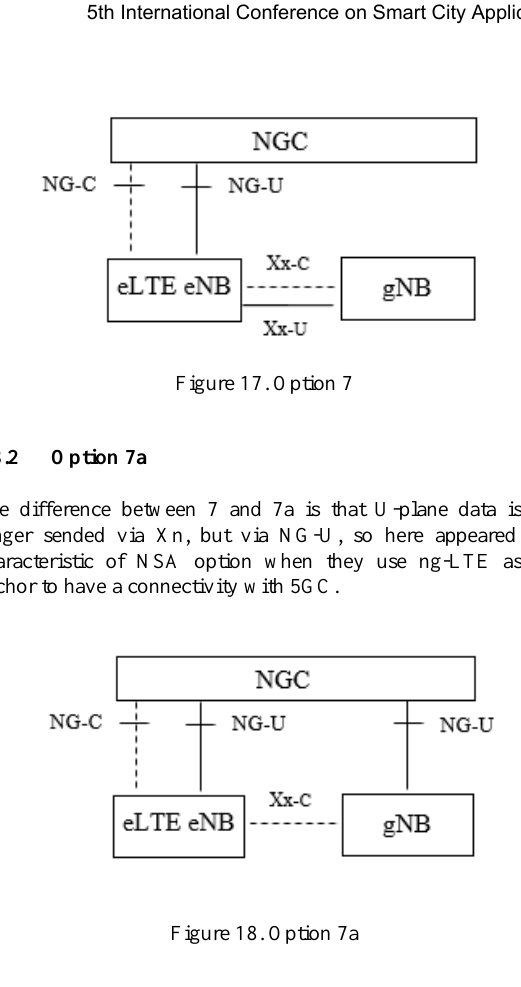
Figure 18. Option